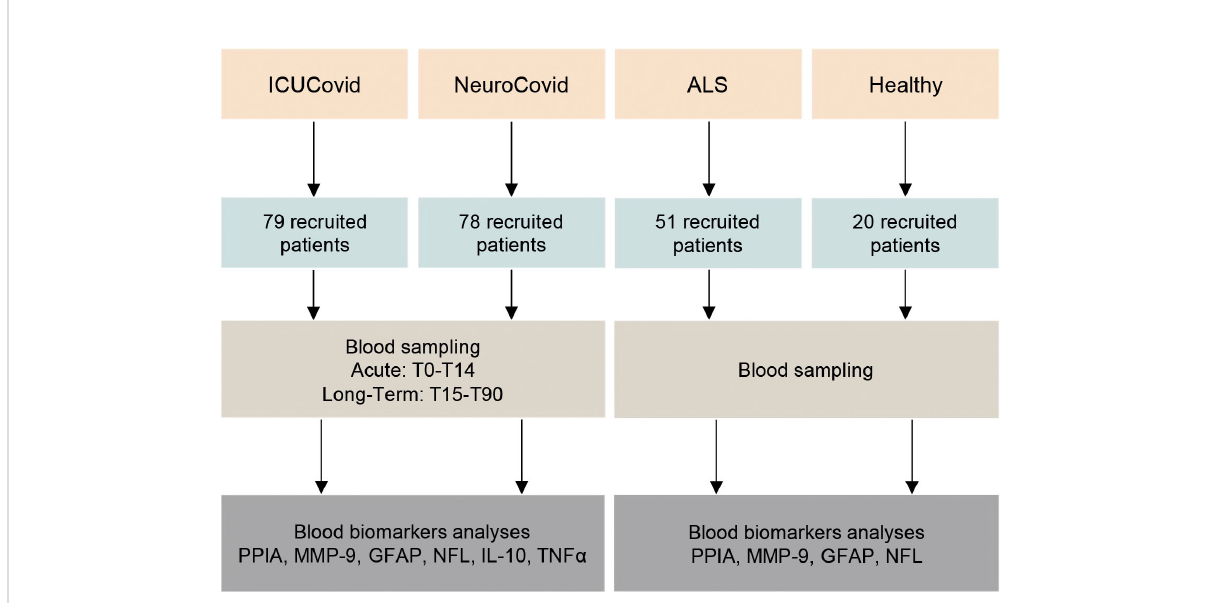
FIGURE 1 Schematic work fl ow for the biomarker characterization in two cohorts of COVID-19 patients and two cohorts of controls (ALS and healthy). The two cohorts of COVID-19 patients analyzed in the study are COVID-19 patients admitted to the ICU ward Rianimazione 1 Fiera Milano COVID- 19 (ICUCovid; n=79) and to COVID-19 wards ASST Papa Giovanni XXIII, Bergamo, with neurological complications (NeuroCovid; n=78). Blood samples were drawn acutely at ICU admission and after 7-14 days (T0-T14), and in the long-term between 15 and 90 days in the ward (T15- T90). Plasma samples were isolated and then analyzed for PPIA, MMP-9, GFAP, NFL, IL-10 and TNF a biomarkers. Control groups were ALS patients (n=51) and healthy subjects (n=20). Plasma samples were isolated and then analyzed for PPIA, MMP-9, GFAP and